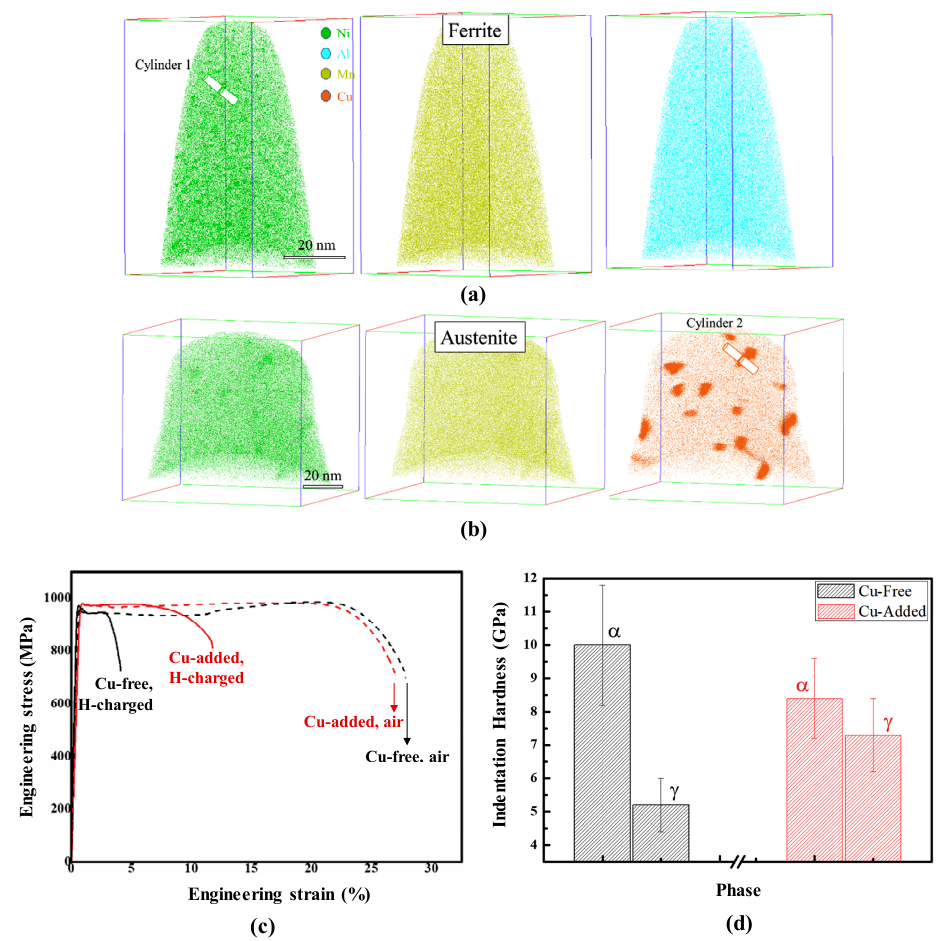
Figure 10. Three–dimensional atom probe tomography (3D–APT) maps for Ni, Al, Mn, and Cu in ( a ) the ferritic and ( b ) austenitic regions in a Cu-added steel (Fe–7Mn–2.5Ni–1.5Al–1.5Cu–0.01C, in wt pct). ( c ) Engineering stress–strain curves before and after H-charging in Cu-free (Fe–7Mn–2.5Ni–1.5Al–0.01C, in wt pct) and Cu-added steels. These two steels were two–stage annealed; the first IA was performed at 630 °C for 1 h, and the second step involved “tempering” at 500 °C. The hold times in the “tempering” step used for the Cu–free and Cu–added steels were 5 and 2 h, respectively. ( d ) Average hardness, measured by nano-indentation, of the ferrite ( α ) and austenite ( γ ) in the Cu-free and Cu-added steels. Reproduced from Reference [56], with permission from Elsevier.